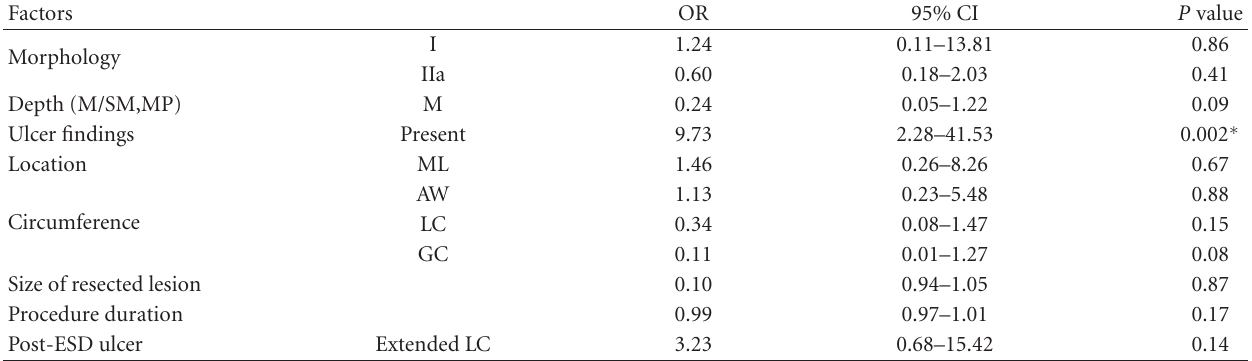
Table 3: Multivariate analysis of delayed